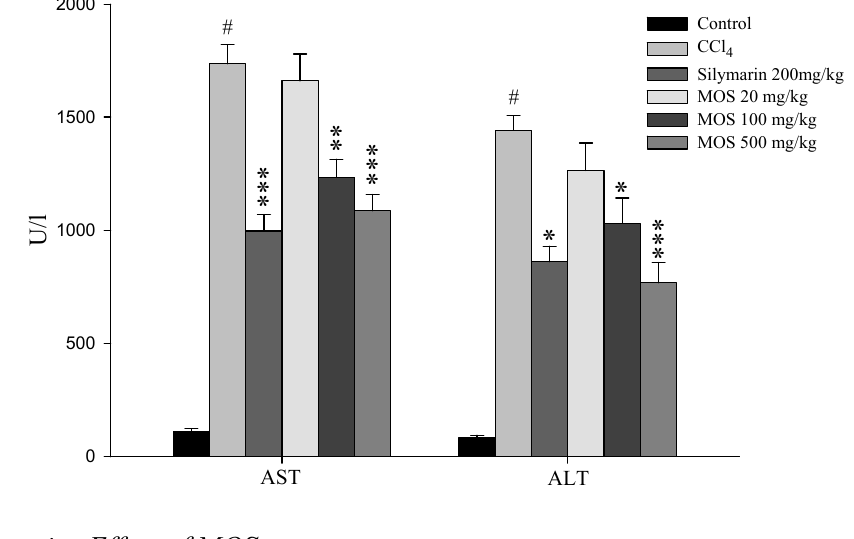
Figure 5. Effect of MOS of serum AST and ALT in rats after intraperitoneally treated EtOH . Values are mean ± SE ( n = 6). # Significantly different from the control group with CCl 4 ( ### p < 0.001); * Significantly different from the CCl group ( * p < 0.05, ** p < 0.01, 4 *** p <